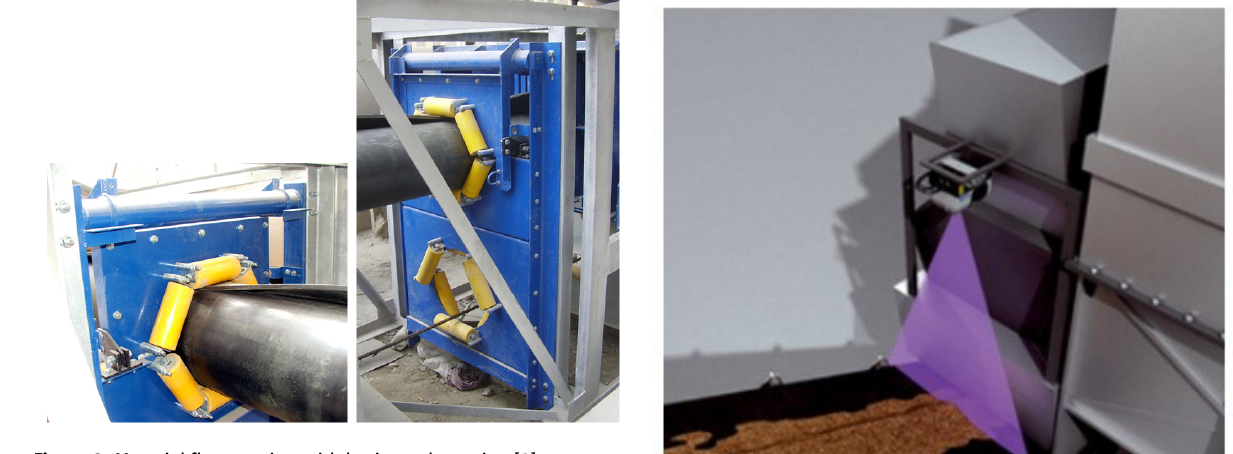
Figure 2: Material flow monitor with horizontal opening [8]